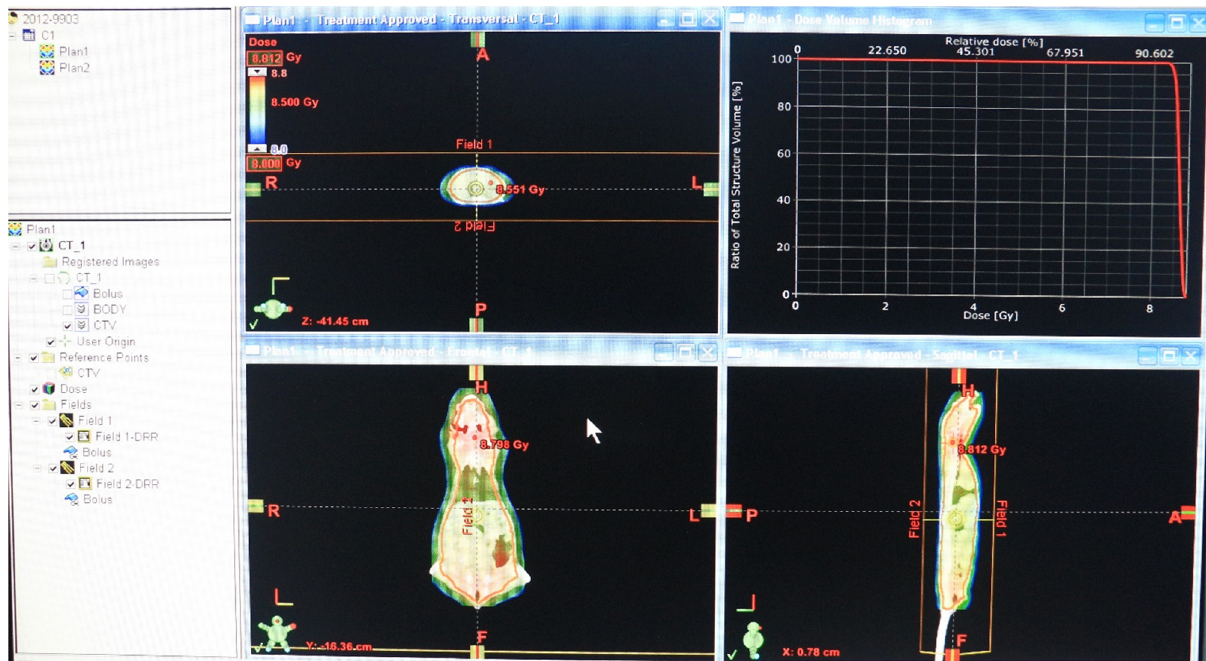
Figure 3: Planning procedure along with the given doses and treatment details.